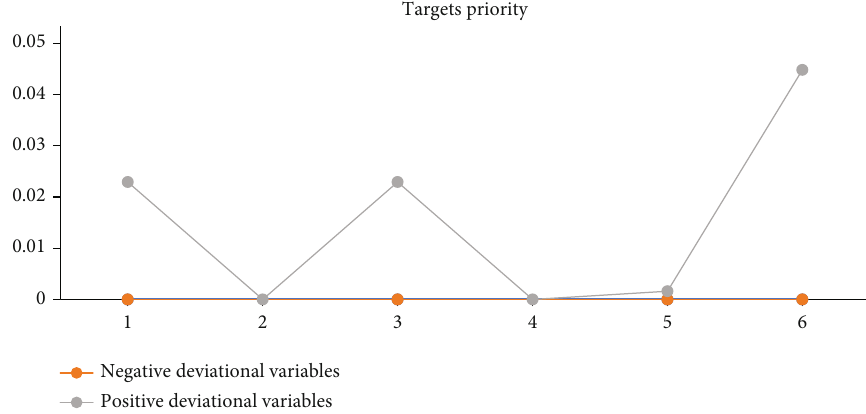
Figure 2: Outcomes of deviational